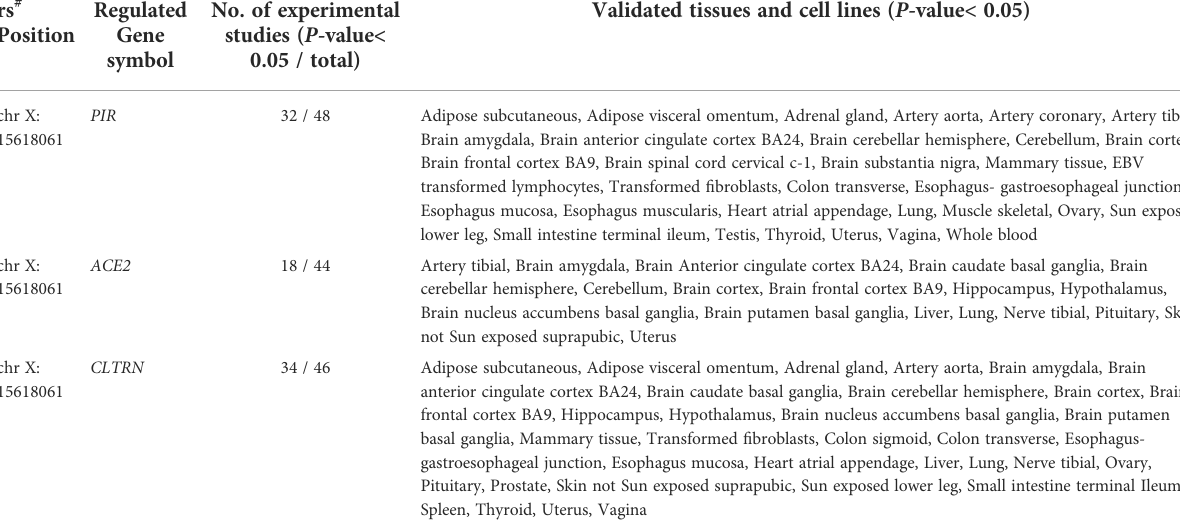
TABLE 9 The eQTL analysis on rs2106809 T>C and functional gene transcription levels by GWAS4D online tool. Regulated rs # Position Gene